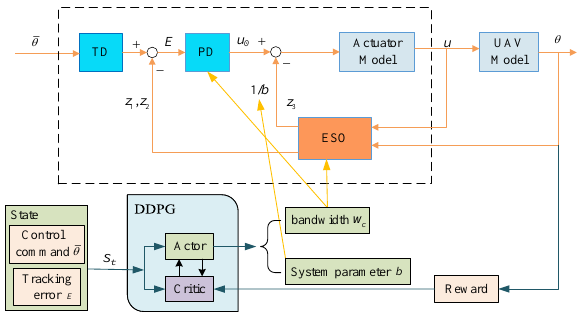
Figure 5. Overall structure of the proposed DDPG-based ADRC